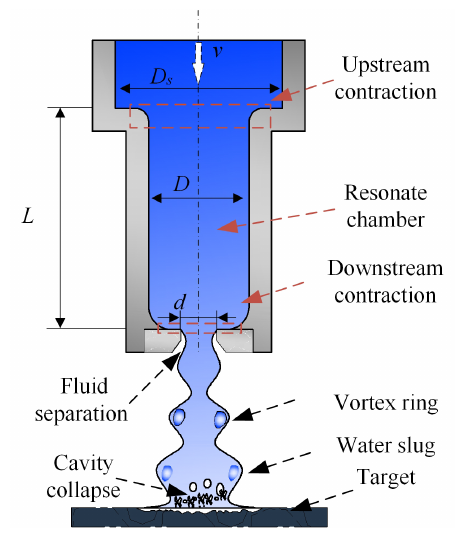
Figure 2. Schematic of the organ-pipe nozzle geometry and generation of a self-excited cavitating waterjet.